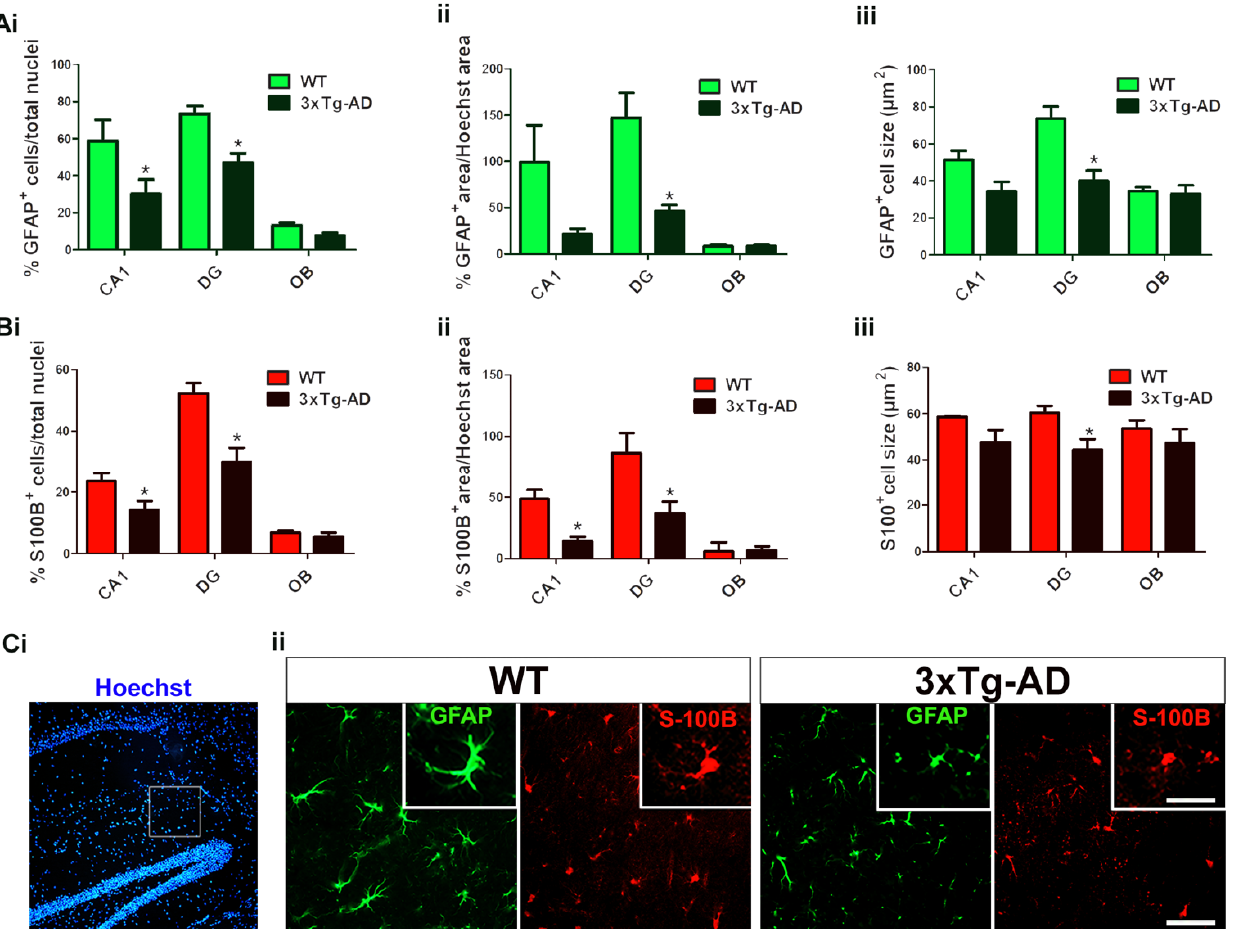
Figure 5. Quantitative analyses of the astrocyte population according to the following; number of cells immunolabeled with GFAP ( A ) or S100B ( B ) over the total cell nuclei ( i ), total area immunolabeled with GFAP or S100B over the total area occupied by cell nuclei ( ii ). Quantitative analyses of the immunolabeled area with GFAP or S100B of individual cells show the astrocyte size ( µ m 2 ) in both genotypes ( iii ). * p < 0.05 vs. WT mice. CA1; hippocampus CA1, DG; hippocampus dentate gyrus, OB; olfactory bulb, including granular and anterior. Hoechst staining of nuclei and double labeling of astrocytes in brain tissue from WT and 3xTg-AD revealing particular immunostaining patterns observed with GFAP and S100B, which stain astrocytic processes or cell bodies, respectively ( Ci and Cii ). Note the marked decrease in the density of astrocytes as well as their atrophy in the transgenic genotype (3xTg-AD). Cii scale bar = 40 µm.